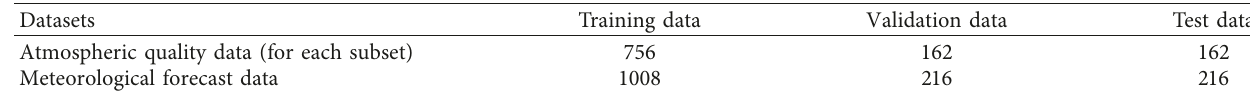
Figure 4: Correlation degrees between SO 2 and effect variables. Table 1: Number of data in the